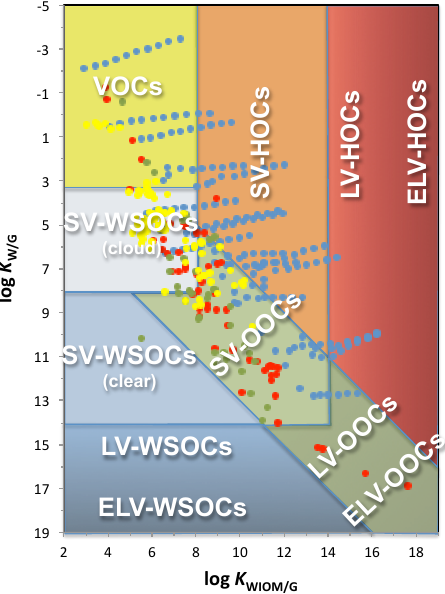
Figure 4. Same as Fig. 2, except that different regions of the chem- ical partitioning space have been named according to the type of compounds that fall into these regions.